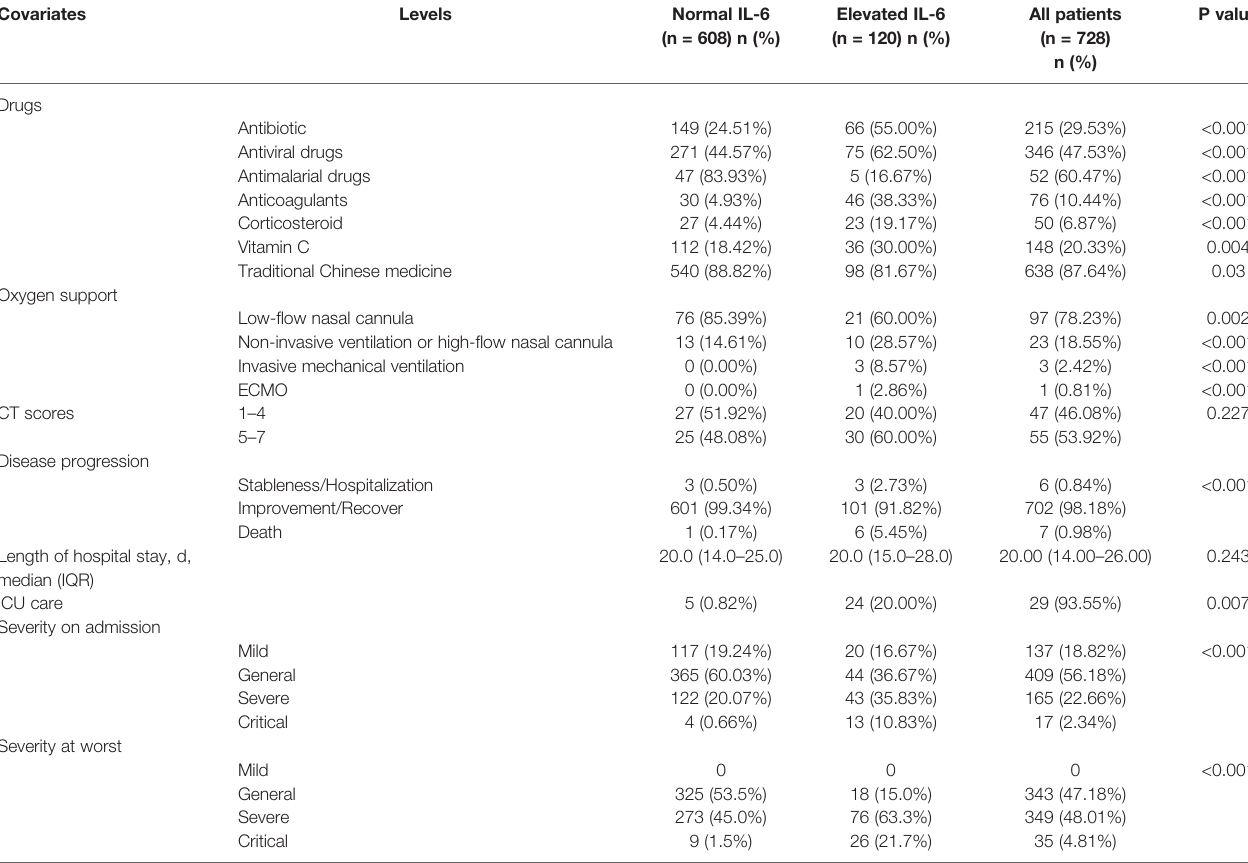
TABLE 3 | Clinical treatments and outcomes of 728 patients with COVID-19. Covariates